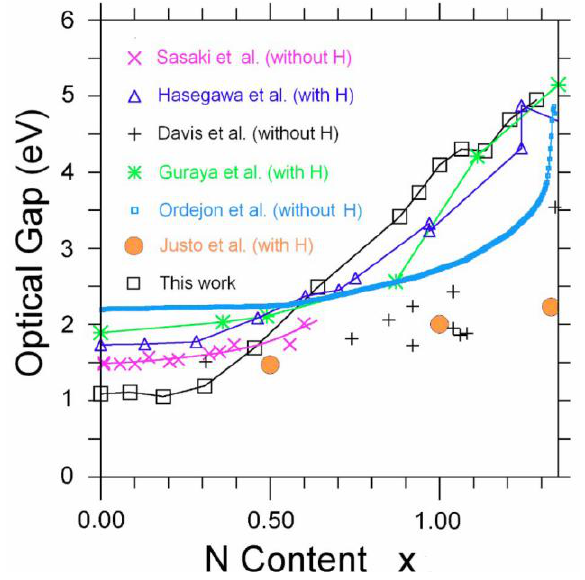
Figure 40. Experimental and calculated optical gaps for amorphous alloys of silicon-nitrogen for various contents x (see text). Lines are drawn as guides to the eye (See References [52] and